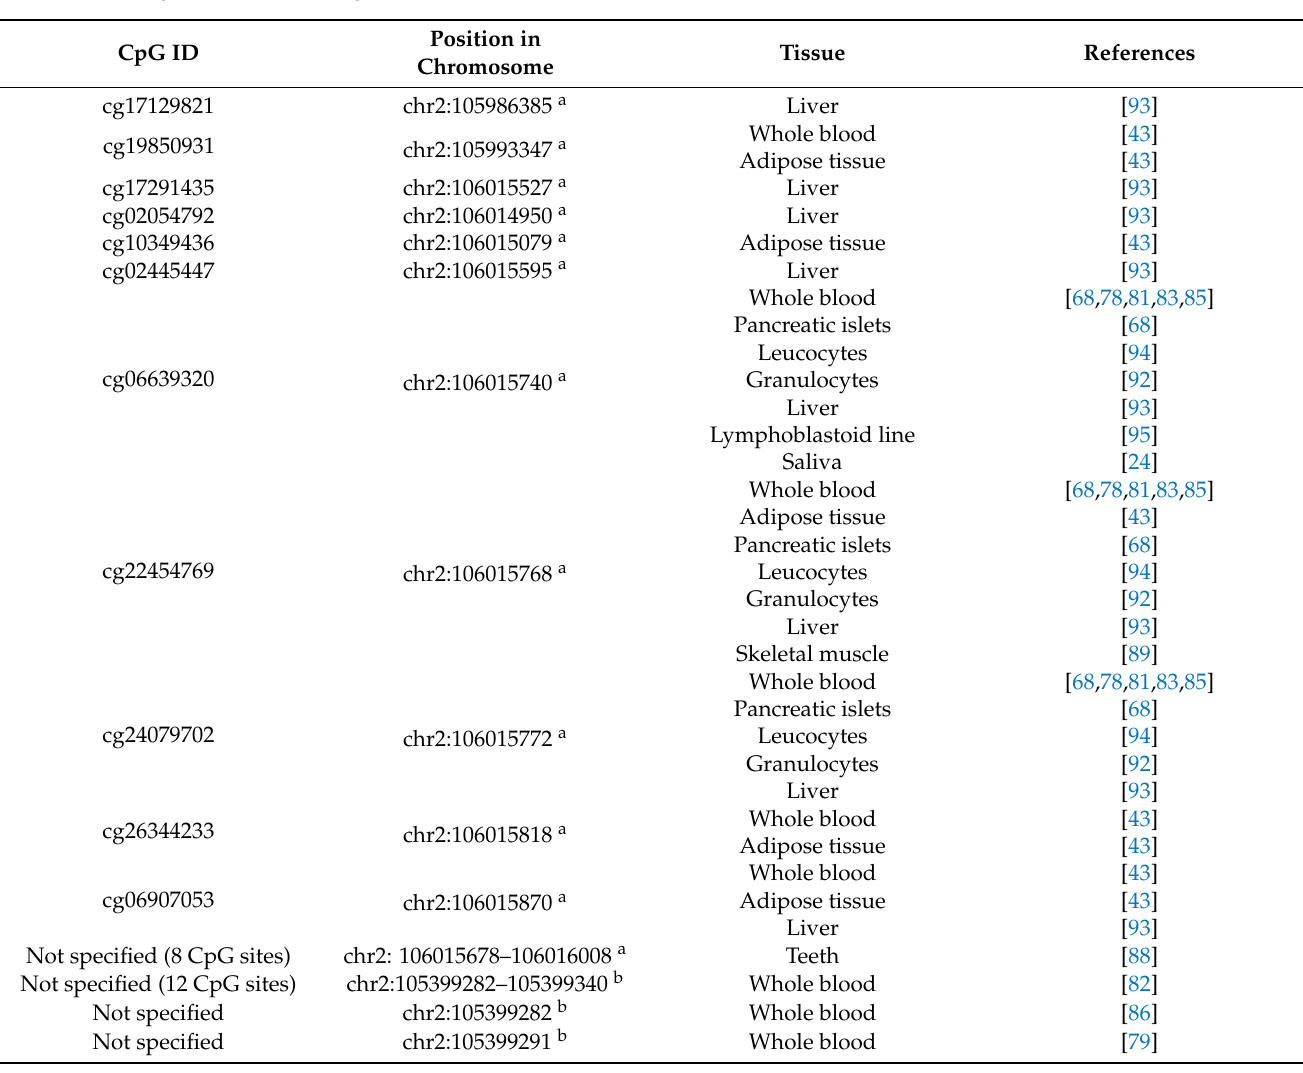
Table 2. Table of CpG sites in the FHL2 gene found in the literature. Position in chromosome based on genome version a GRCh37/hg19 or b